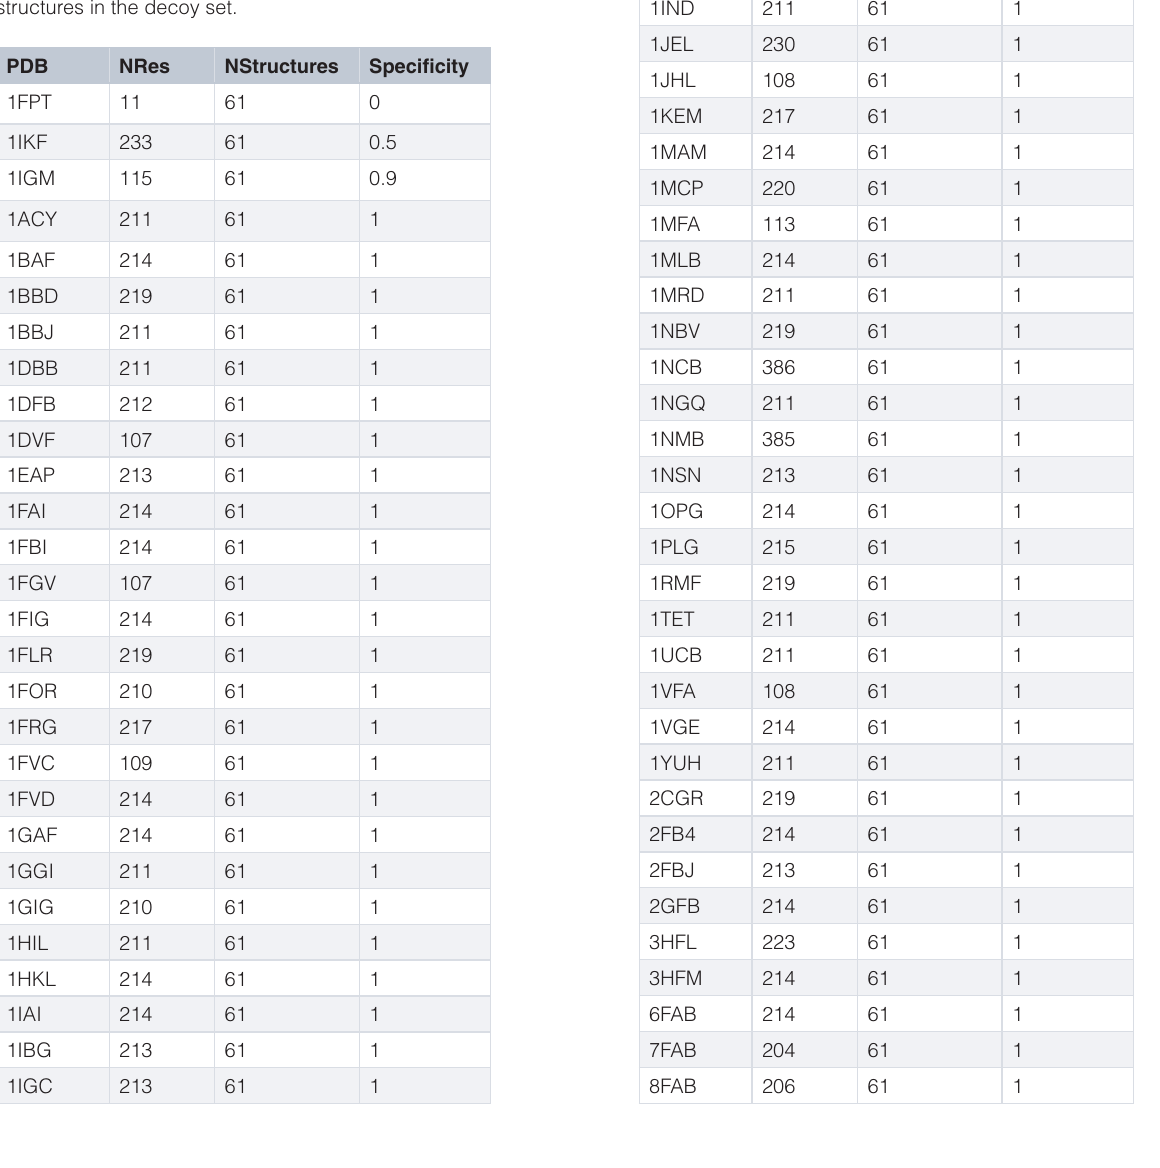
Table S2. ig_structal decoy set. The PDBs are sorted based on specificity: The ig_structal decoy set has ~61 protein structures - each of which has 61 structures. The average specificity obtained for the set is 0.97. NRes =: number of residues, NStructures =: number of structures in the decoy